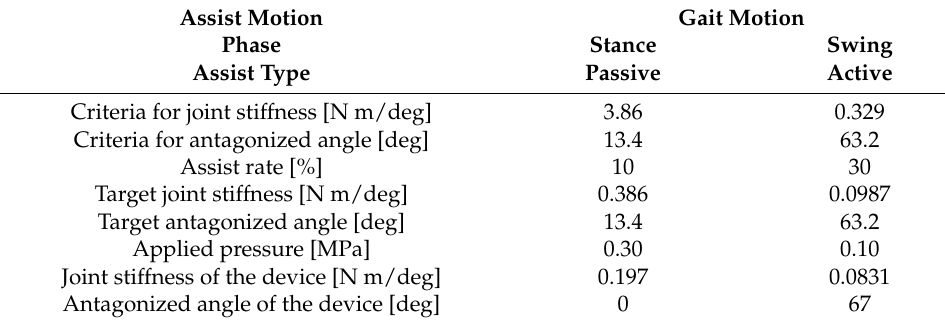
Table 6. Assist target values in the gait